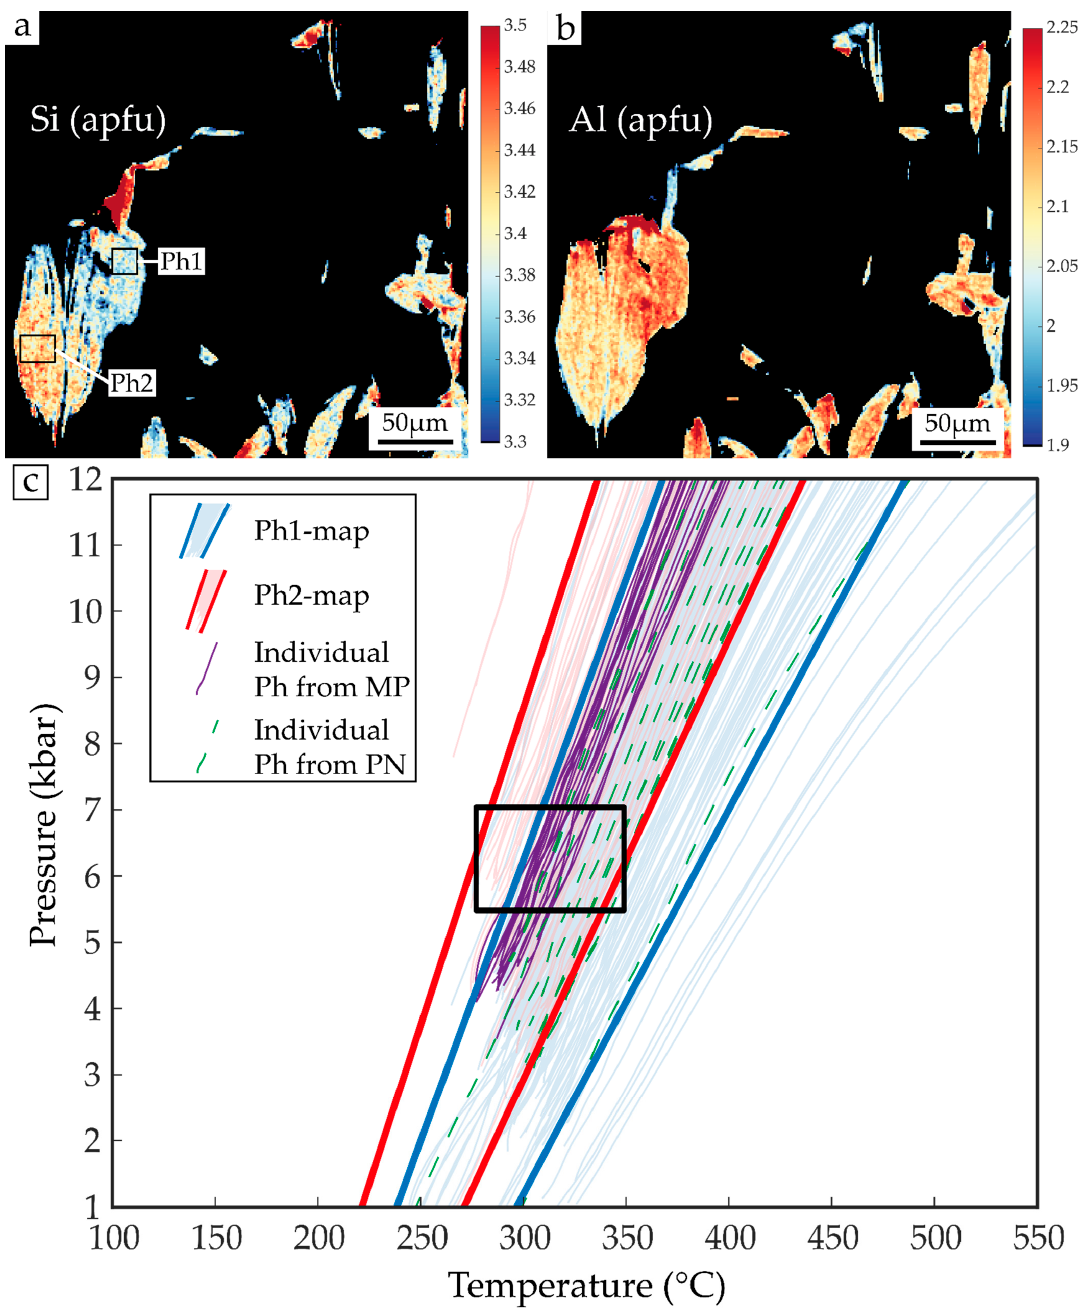
Figure 9. ( a , b ) Quantified X-ray phengite maps (in apfu) of the Si content ( a ) and the Al content ( b ). The black boxes show the pixel zones analyzed. ( c ) Phengite P-T estimates (lines) using the method of Dubacq et al. [59]. The box is constructed using the result of Chl3 thermometry (Figure 8f) and the punctual data. For a given temperature, pressure has been estimated using the phengite P-T equilibrium lines of the punctual data from the map area. Boundaries of the Ph1 and Ph2 were determined using more than 95% of P-T lines for each zone.